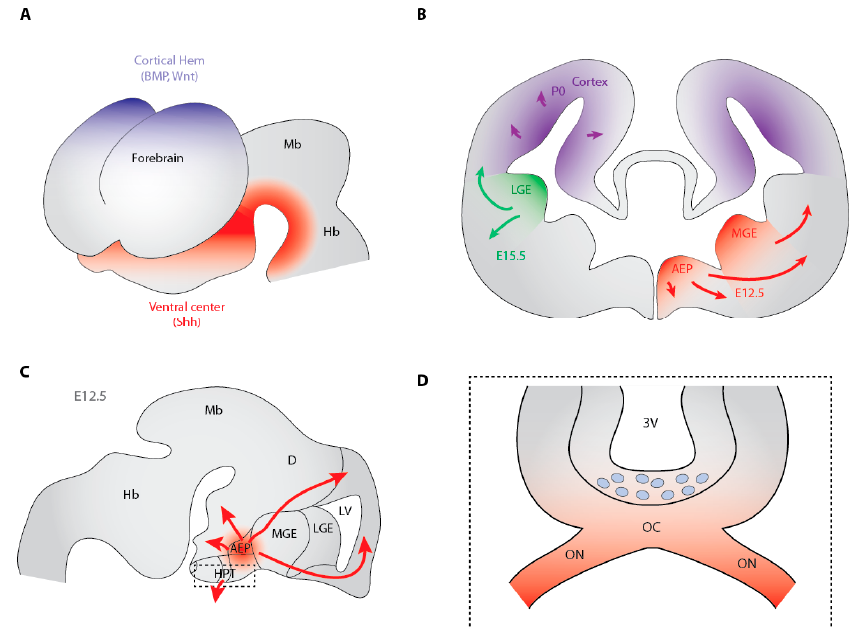
Figure 3. Hedgehog-dependent generation of the OL lineage cells in the brain. ( A ) Scheme visualizing the ventral ( red ) and dorsal ( blue ) organizing centers of the forebrain which secrete Hedgehog and BMP/Wnt, respectively; ( B ) Cross-sectional view of the mouse telencephalon indicating the regions of the ventricular zone where the different waves of OPCs are generated. The earliest wave (E12.5, red) arises from Nkx2.1-expressing precursors, which appear in the anterior entopeduncular area (AEP) and medial ganglionic eminence (MGE) and then migrate into all parts of the telencephalon. The second wave derives from Gsh2 + precursors located in the lateral ganglionic eminence (LGE, green) at E15.5. The last wave emerges from Emx1-expressing cortical precursors ( blue ) around birth; ( C ) Sagittal view of the brain indicating the position of the developing hypothalamus which also generates OPCs in E12.5 mouse embryo; ( D ) Coronal view of the hypothalamic region indicated by the boxed area in ( C ). The localization of the Shh protein (red) transported through the optic nerves (ON) towards the optic chiasm (oc) is shown. The OPCs ( blue ) generated in the floor of the third ventricle (3V) in a Hedgehog-dependent manner at E12.5 in mice are aimed at colonizing the optic nerves. D, diencephalon; Hb, hindbrain; LV, lateral ventricle; Mb, midbrain.